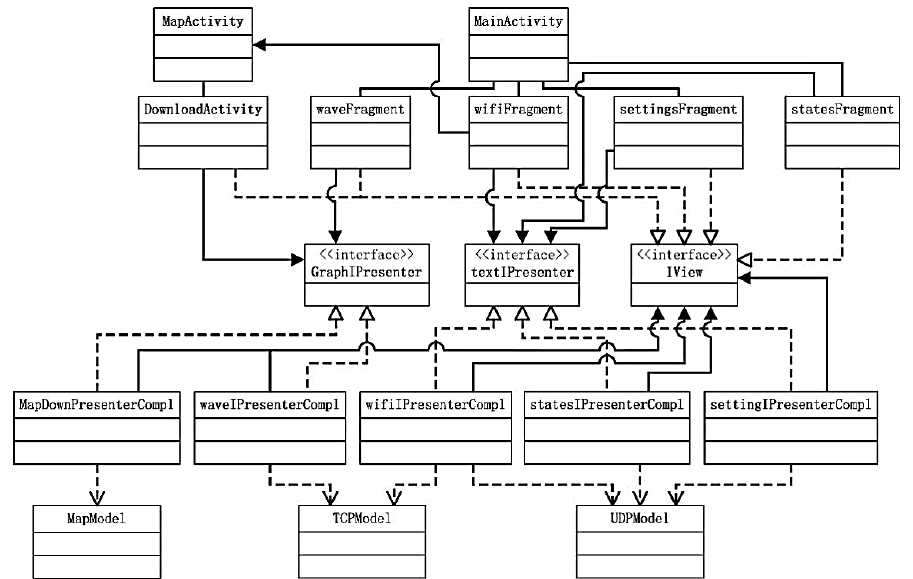
Figure 2. Application programming